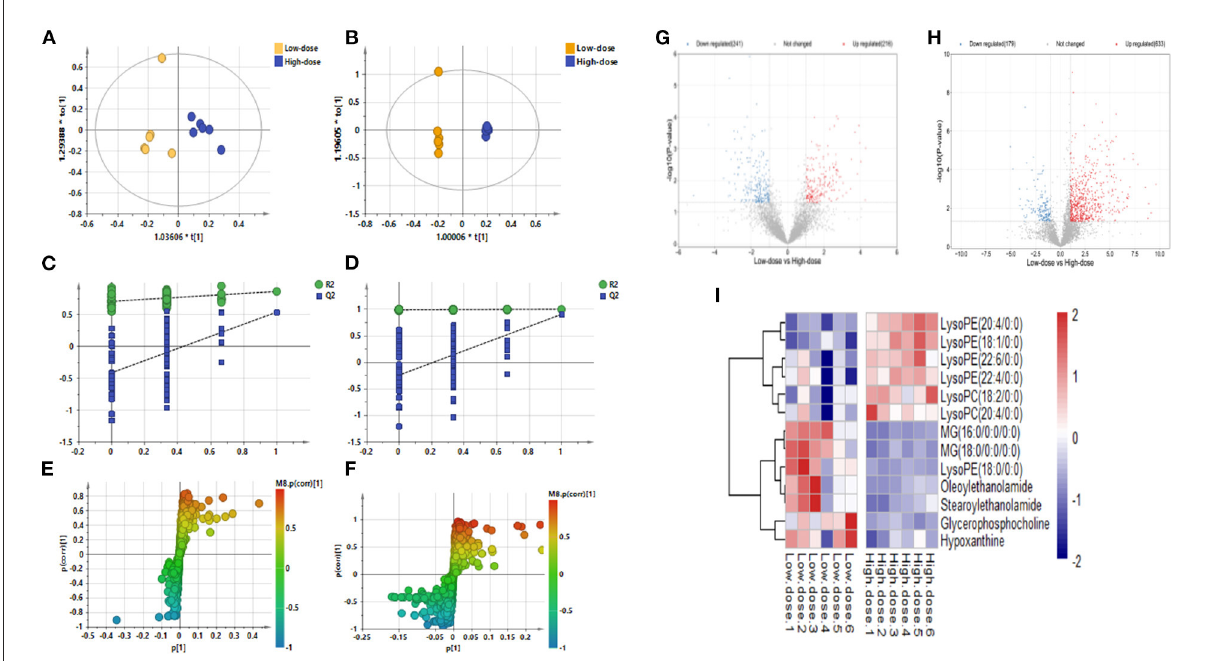
FIGURE4 OPLS-DA: Low-dose vs. High-dose. (A) Negative ions (R 2 X 0.562, R 2 Y 0.860, Q 2 0.536), (B) Positive ions (R 2 X 0.874, R 2 Y 0.999, Q 2 0.901), (C) Negative ion replacement test, (D) Positive ion replacement tests, (E) Negative ion S-plot, (F) Positive ion S-plot. (G,H) Volcano diagram. (G) Negative ions, (H) Positive ions. ‹ Fold change (M/C) > 2 or < 0.5, and › P < 0.05 was the effective variable. Blue means down, red means up. (I) Low-dose vs. High-dose differential metabolite heat map. The darker the red, the higher the response, and the darker the blue, the lower the response. It can be seen that the response of most compounds decreased significantly after the administration of low concentrations.